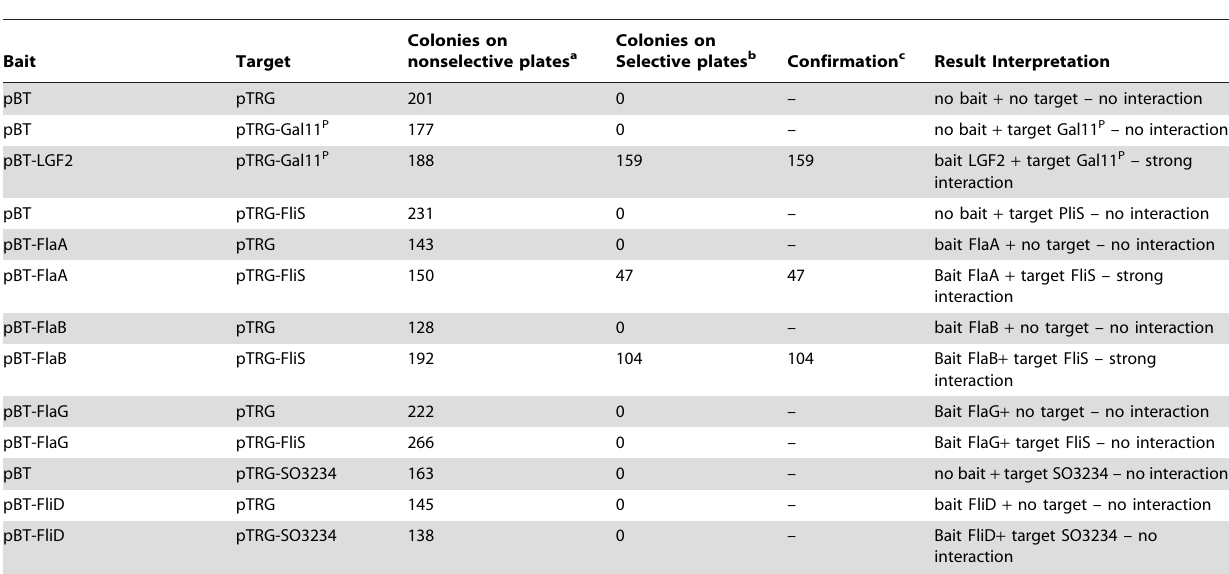
Table 3. Bacterial two-hybrid assay of FliS-FlaA, FliS-FlaB, and SO3234-FliD.